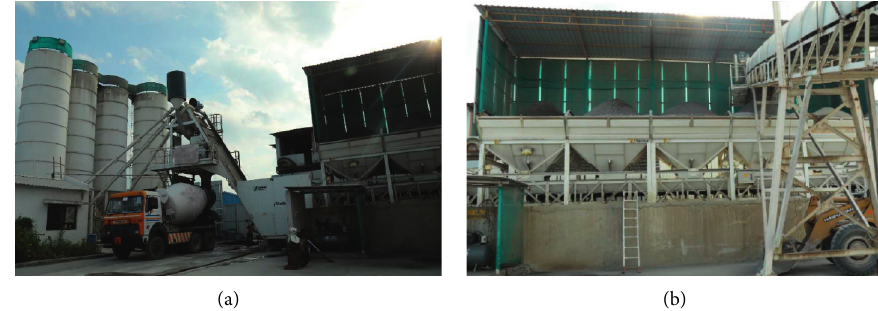
Figure 2: (a) Discharge of aggregate from the conveyor to the mixing chamber. (b) Aggregate stored in the storage bin.